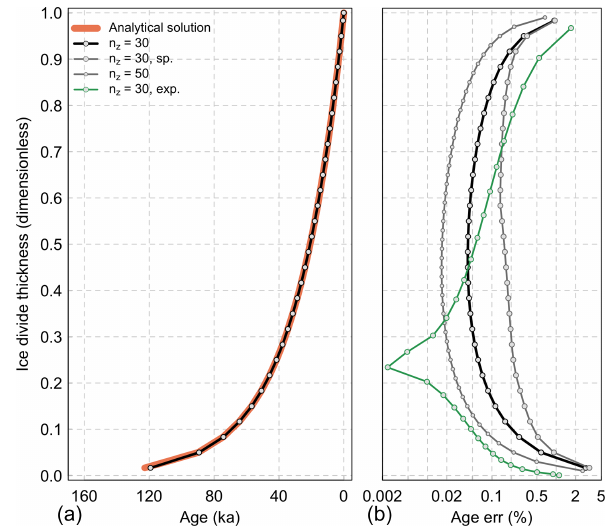
Figure 9. Analytical age–depth profile for idealized summit com- pared to Yelmo Eulerian age tracing. (a) The ice age relative to present day is shown for the analytical solution (thick, light-red line) and Yelmo with a resolution of n z = 30 with a linear vertical axis and compiled at double precision (black line). (b) The associ- ated relative error is given for this case (black line), as well as for a higher resolution of n z = 50 and for n z = 30 compiled at single pre- cision (grey lines), and finally for a resolution of n z = 30 compiled at double precision but with exponentially increasing resolution at the base instead of a linear axis (green